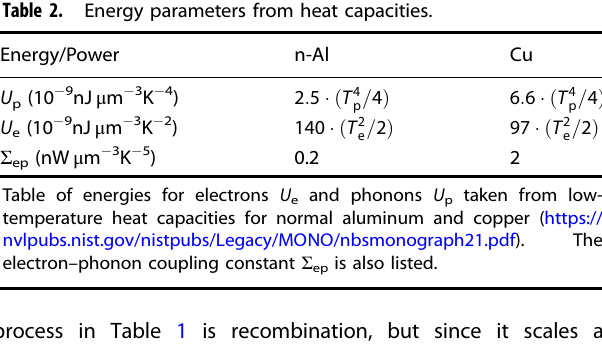
Fig. 3 Phonon decay rate. Plot showing the phonon decay rate versus phonon energy of Eq. (8) (black dots), compared to a normal metal (red line). No pair-breaking occurs below energy 2 Δ , as expected. The rate above 2 Δ is described well by the fi t function of Eq. (9) (blue line). Table 2. Energy parameters from heat capacities.